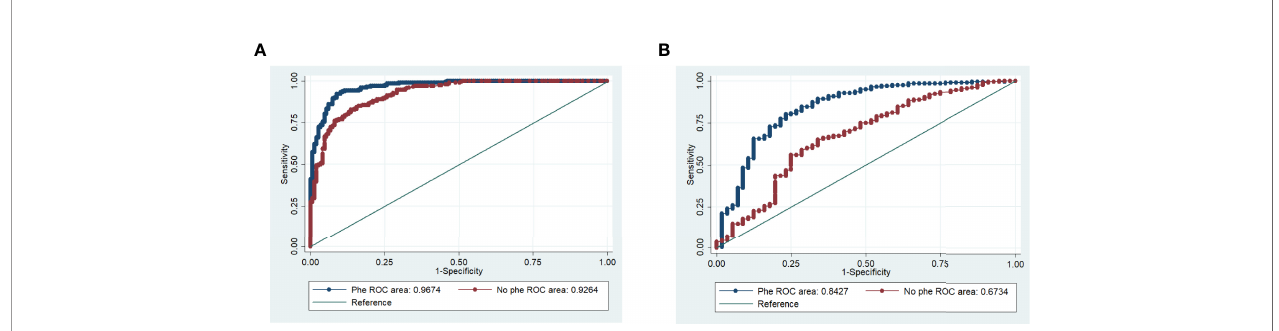
FIGURE 4 | Receiver operating characteristic (ROC) curves for phenylalanine. (A) Phenylalanine in mild vs. critical model, adjusted by covariates. (B) Phenylalanine in severe vs. critical model, adjusted by covariates (all p ≤ 0.003).